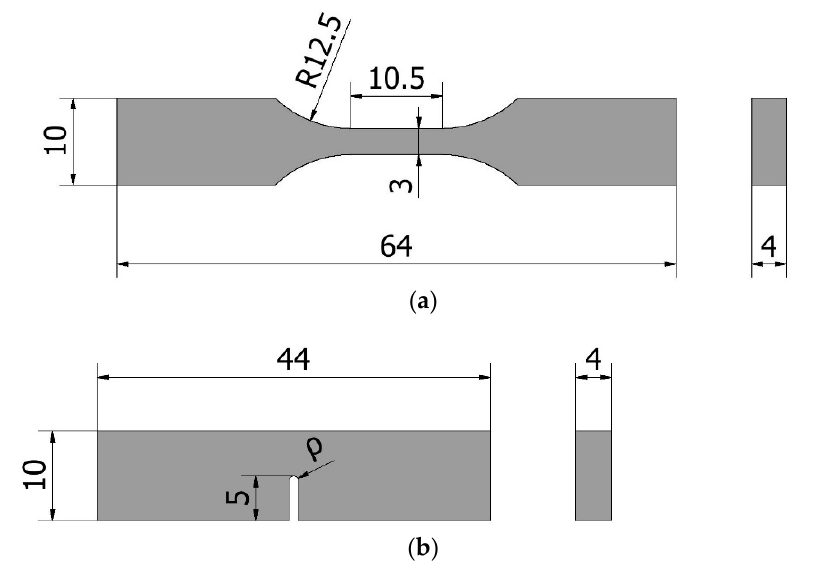
Figure 4. The geometry of the ABS AM specimens: ( a ) tensile specimens; ( b ) fracture specimens, with ρ varying from 0 mm up to 2 mm. Dimensions in mm.